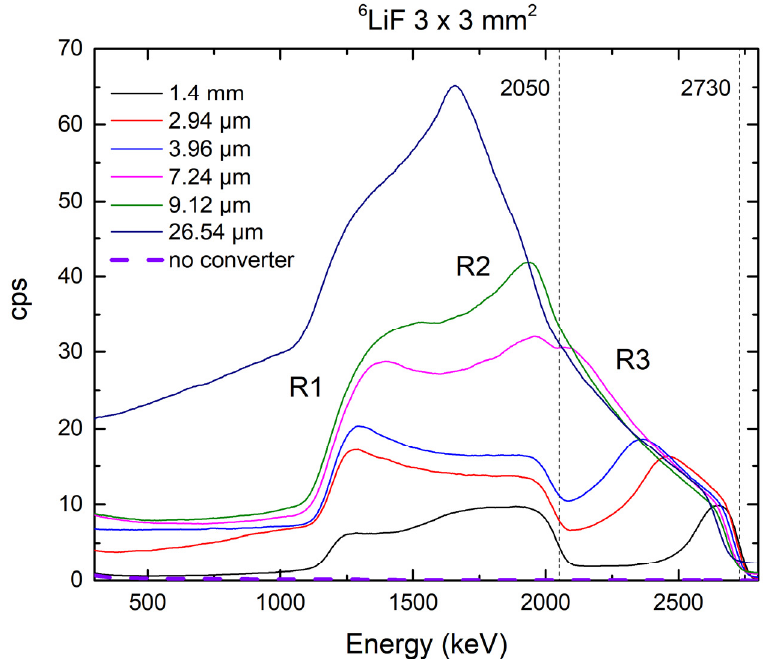
Figure 2. Response of the 4H-SiC SBD detector (3 mm × 3 mm) equipped with 6 LiF thermal neutron converter layers with different thicknesses to the neutron field of the JSI TRIGA reactor at 250 kW.